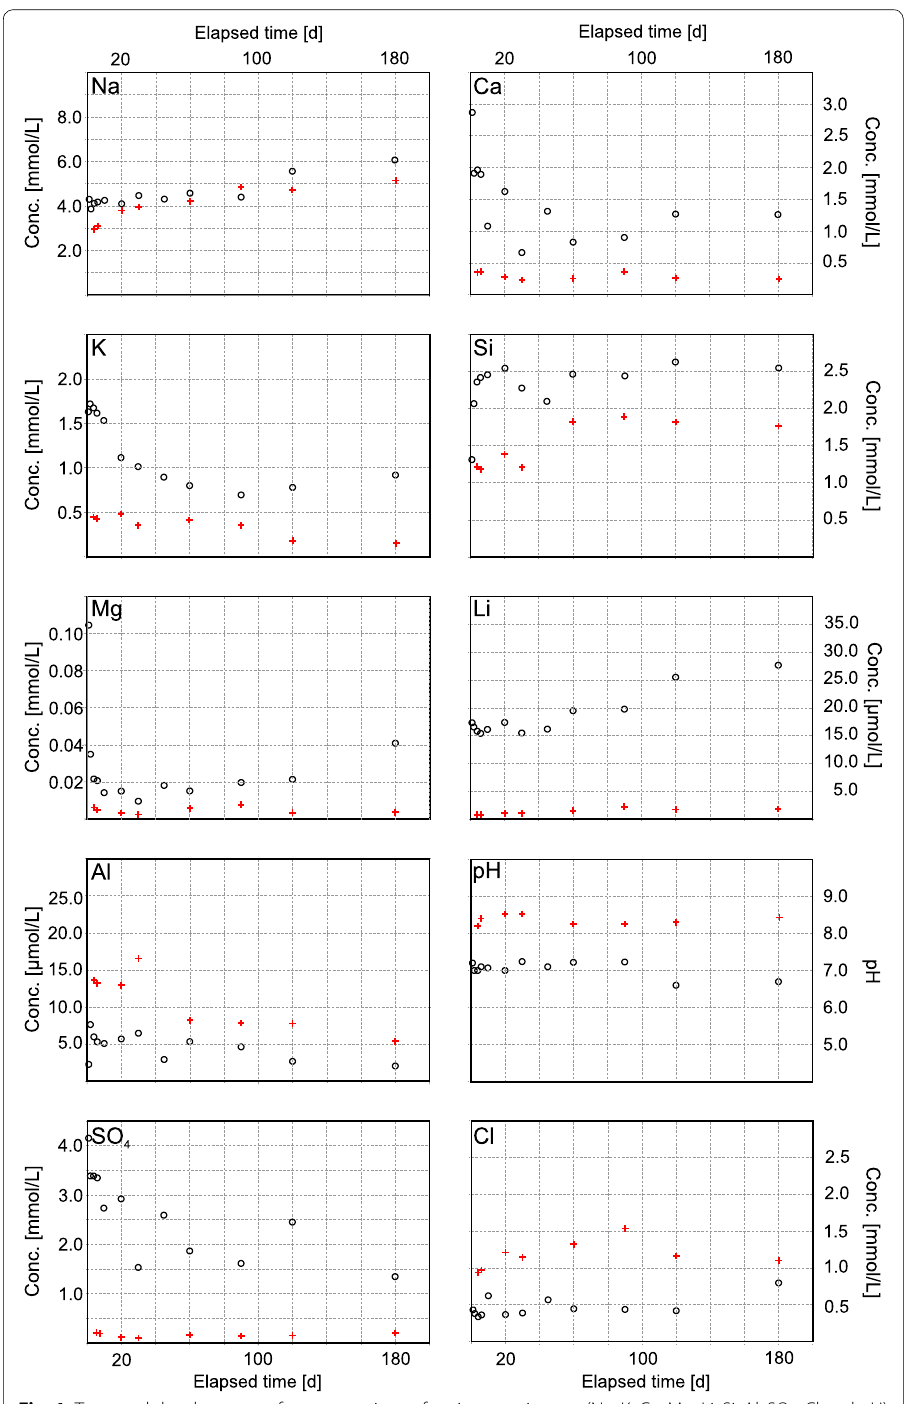
Fig. 1 Temporal development of concentrations of major constituents (Na, K, Ca, Mg, Li, Si, Al, SO 4 , Cl and pH) of the laboratory equilibration experiments plotted versus elapsed reaction time (tonalite experiments black circles , andesite experiments red crosses